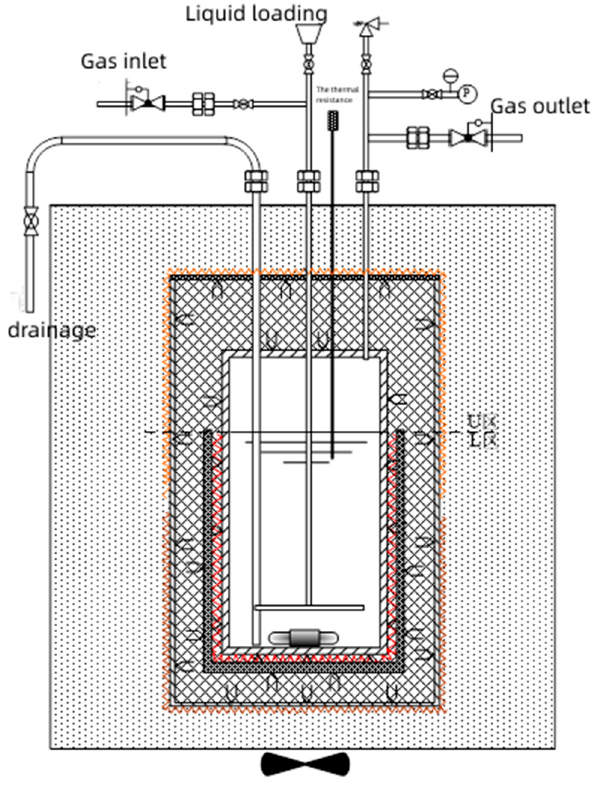
Figure 2. Reactor design model of reaction heat tester.